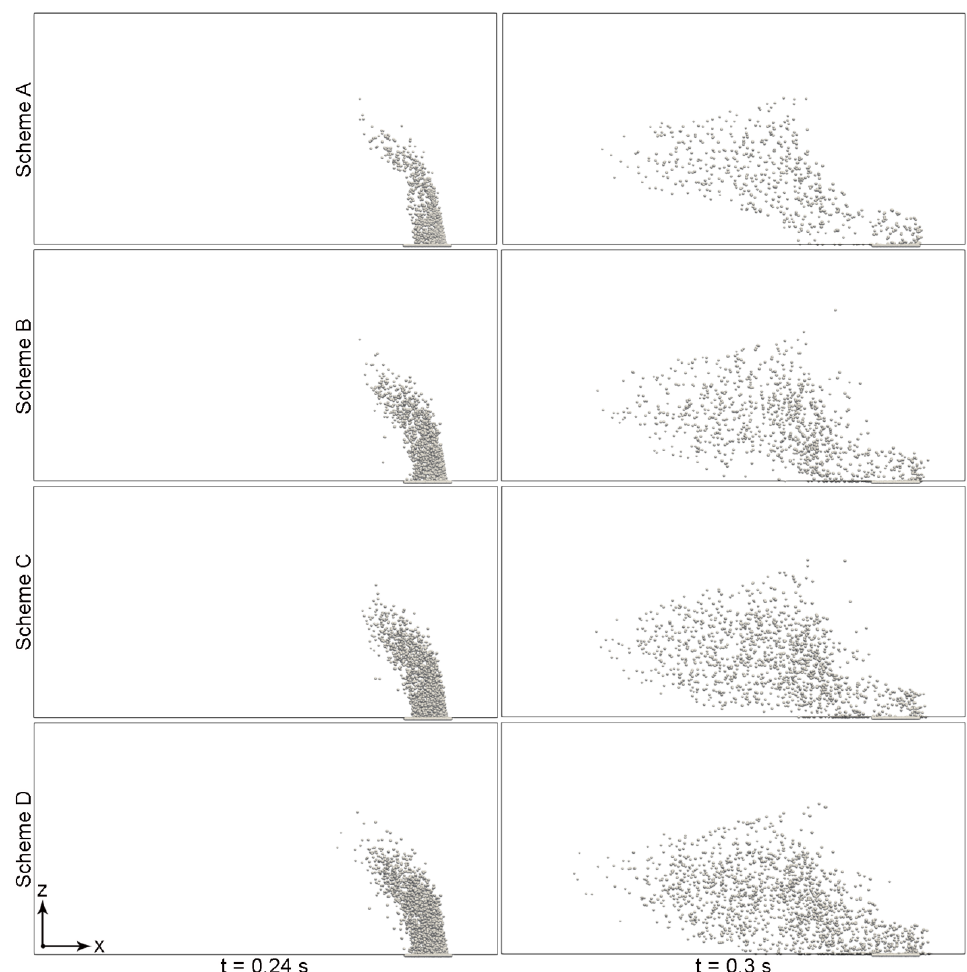
Figure 7. Main view of particle distribution at different moments for different simulation schemes (the particles are enlarged 15 times to visualize the particle positions).